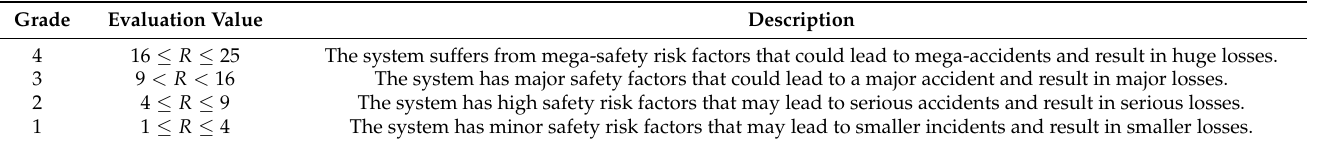
Table 5. The divisions of the safety risk grades.